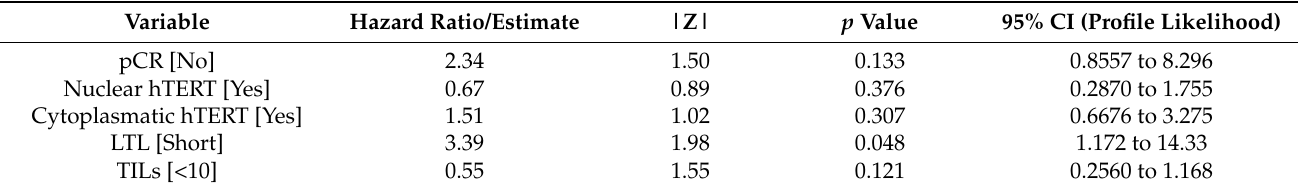
Table 6. Multivariate Cox